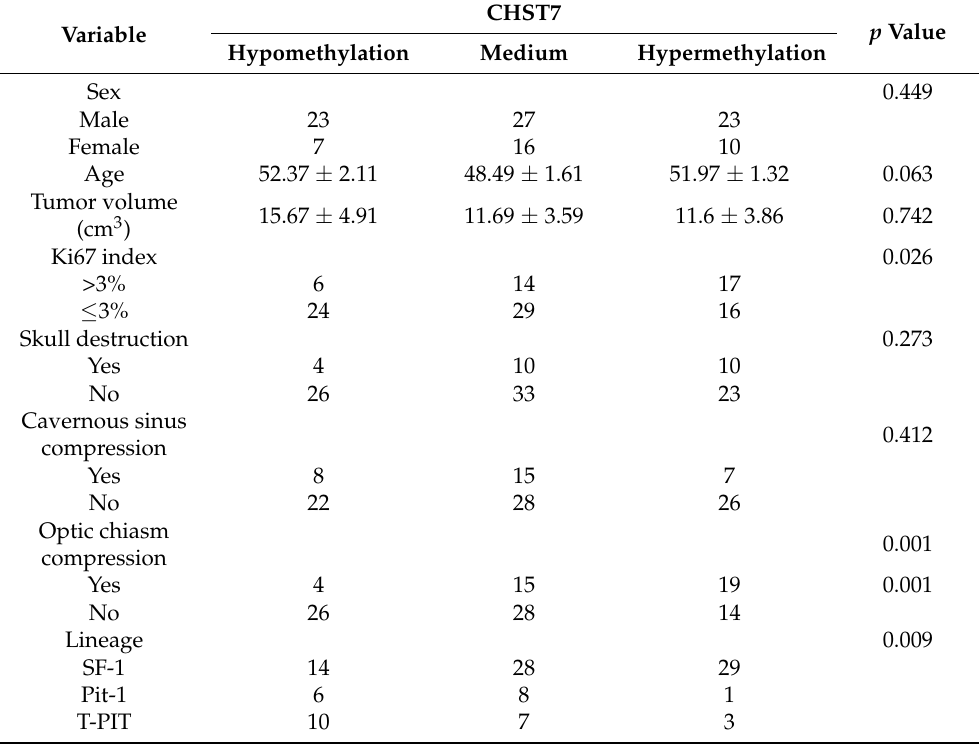
Table 2. Correlation between CHST7 methylation and clinicopathologic features in 106 patients.